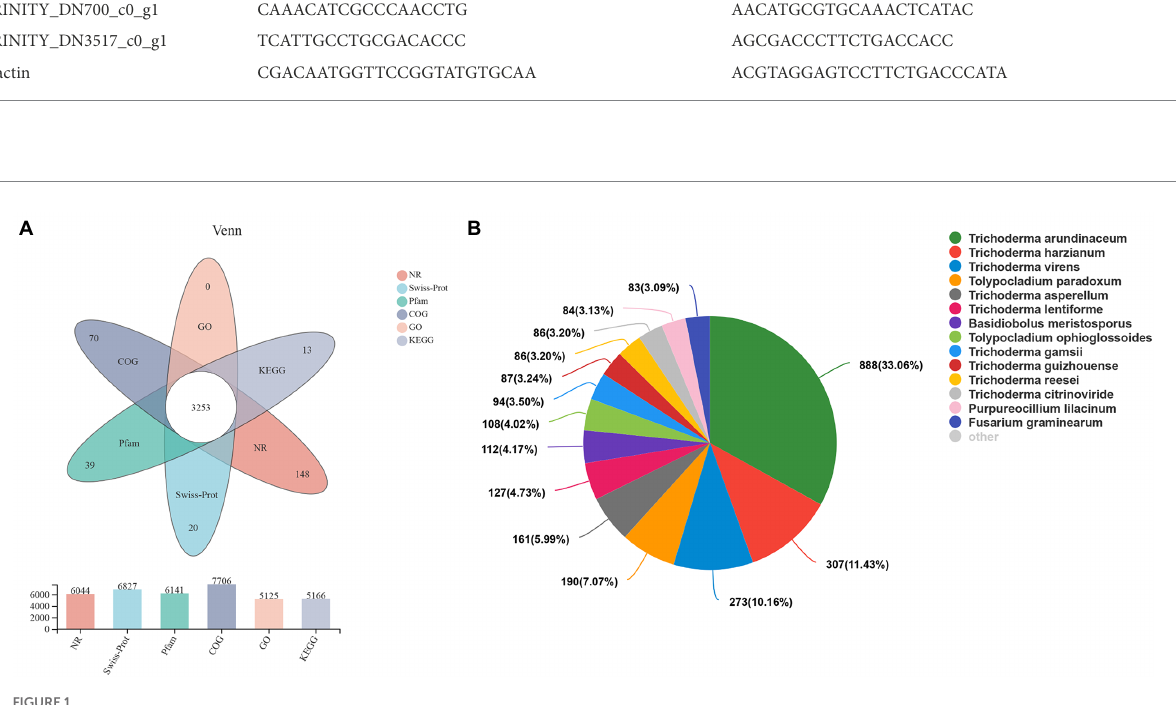
FIGURE 1 Transcriptome sequencing of Hypomyces chrysospermus . (A) Venn diagram of unigenes annotated in public databases, including Swiss-Prot, COG, KEGG, GO, and Pfam databases. (B) Species distribution of all annotated